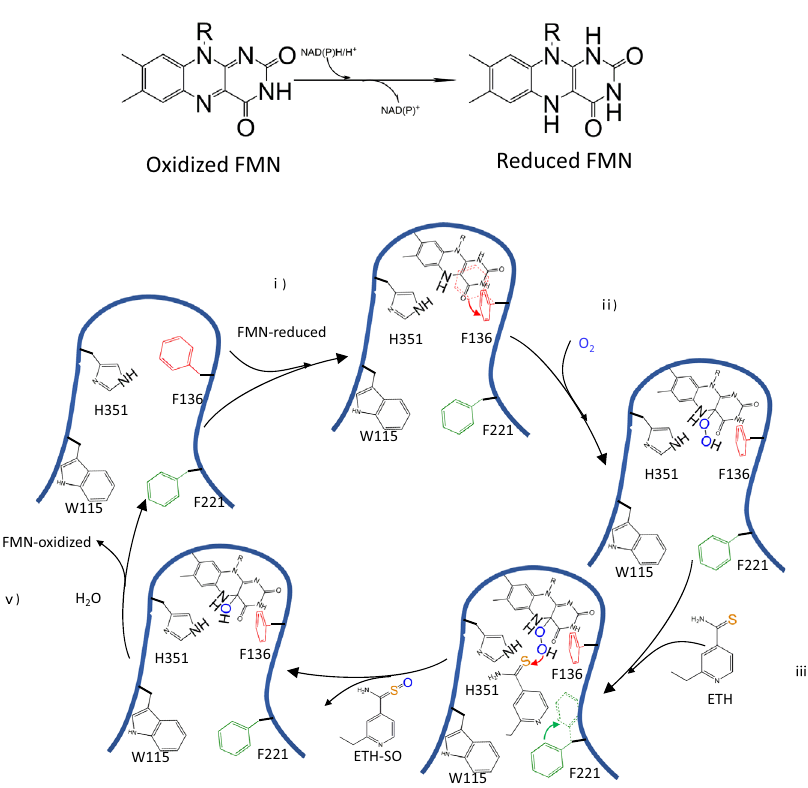
Fig. 7 Model of catalytic events at the Rv3094c active site. Conversion of oxidized FMN to reduced FMN and schematic showing a model of the catalytic events that occur in the Rv3094c active site. (i) Conformational change occurs at F136, leading to Rv3094c binding of reduced FMN. (ii) An electron from reduced FMN then transfers to oxygen, forming the hydroperoxy fl avin intermediate. During this process, H351 acts as a proton donor, stabilizing the hydroperoxy fl avin intermediate. (iii) Opening of the gate between the fl avin ring and ethionamde by conformational change in F221 allows ethionamide contact with hydroperoxy fl avin and incorporation of an oxygen atom. Meanwhile, another oxygen atom is reduced, forming a water molecule. (iv) When the hydroperoxy fl avin intermediate dissolves, the gate between the fl avin ring and ethionamide closes, ethionamide sulfoxide is released, and (v) the oxidized FMN coenzyme within Rv3094c, together with NAD(P)H, starts a new cycle of ethionamide